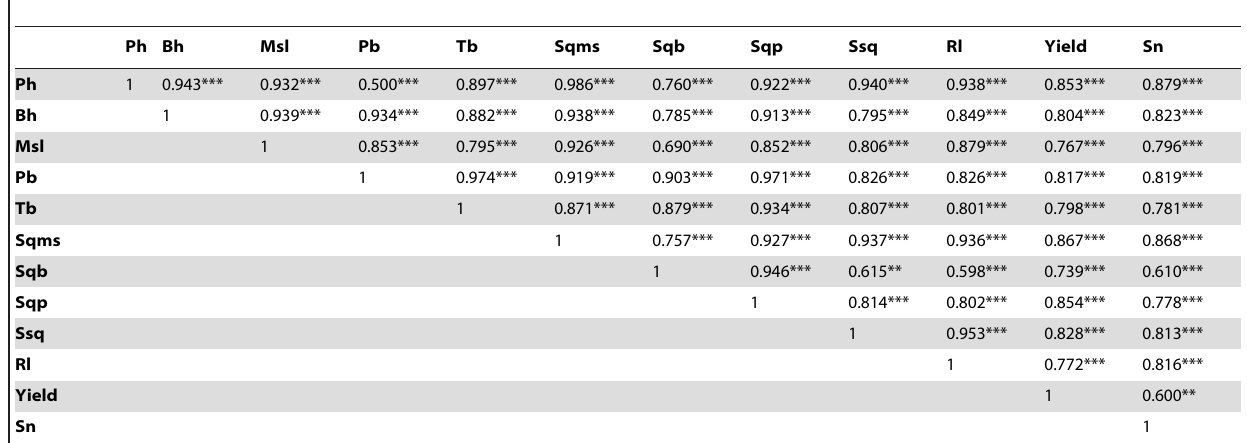
Table 2. Correlation coefficients ( r ) between pairs of yield related traits after waterlogging.